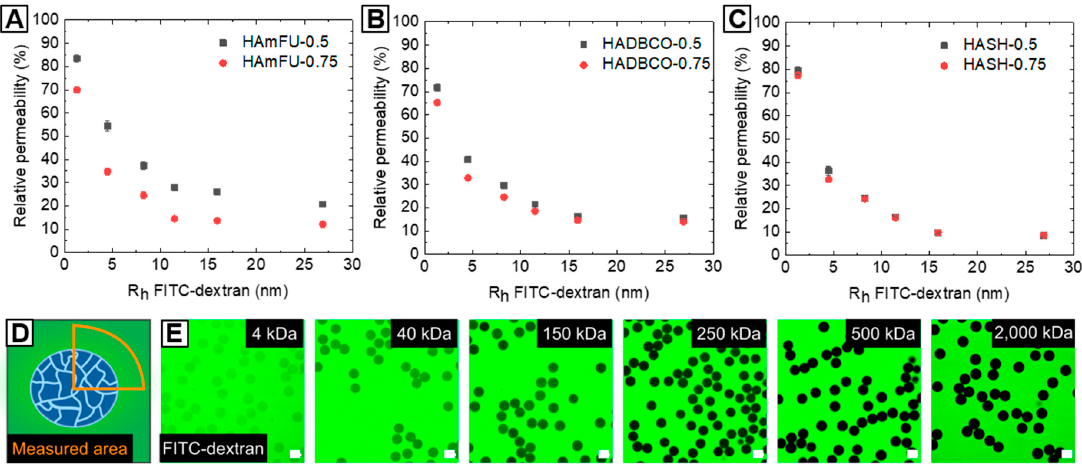
Figure 6. Analysis of HA-microgel permeabilities based on the diffusion of FITC-dextrans of different molecular weights into the microgel networks. ( A – C ) Plots of relative permeability versus hydrodynamic radii of FITC-dextrans. Relative permeability of ( A ) HAmFU-microgels, ( B ) HADBCO-microgels, and ( C ) HASH-microgels determined by comparing fluorescence intensity between the microgel volume and the surrounding media, as schematically illustrated in ( D ) (n = 15; mean ± SD). The molecular weights of FITC-dextran are correlated to their hydrodynamic radii in PBS [65,66], as detailed in Table A2. ( E ) Exemplary confocal microscope images of FITC-dextran-incubated HAmFU − 0.5 microgels. The scale bars denote 50 µm.